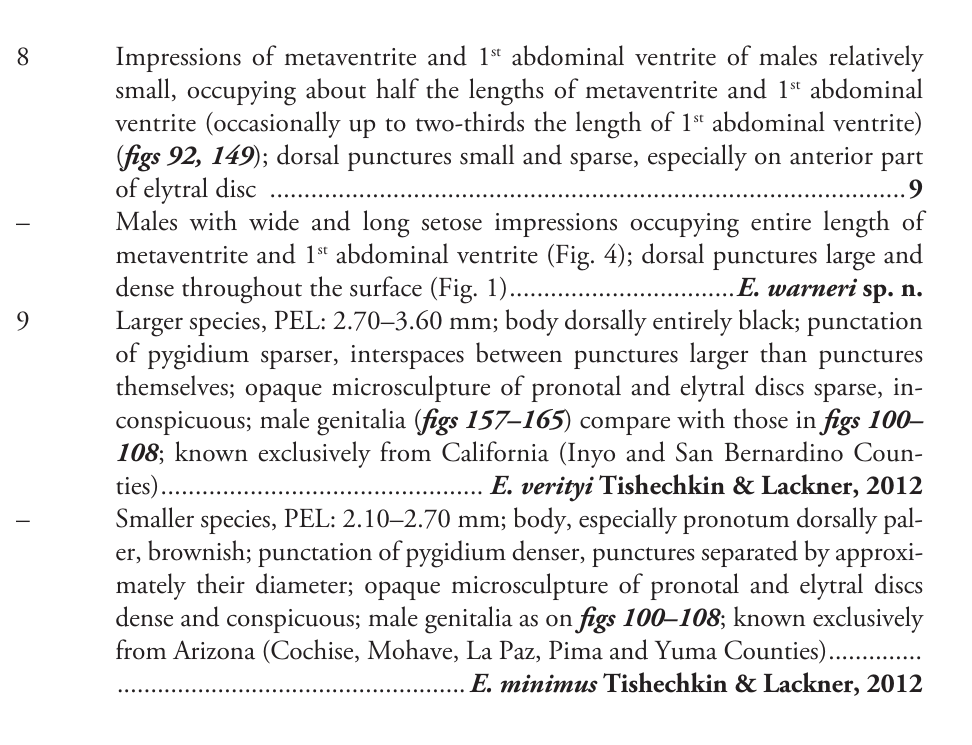
Taxonomy Eremosaprinus warneri sp. n.